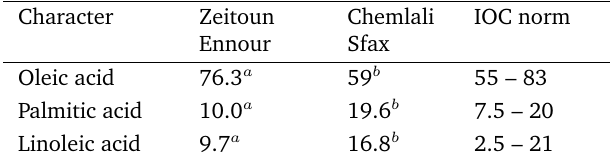
Table 3. Mean fatty acid concentrations (%) of the new cultivar ’Zeitoun Ennour’ compared with ‘Chemlali Sfax’ and corresponding IOC norms (International Olive Council, 1997b). For each fatty acid, different letters following the means indicate significant differences at 5 % level Character Zeitoun Chemlali IOC Ennour Sfax